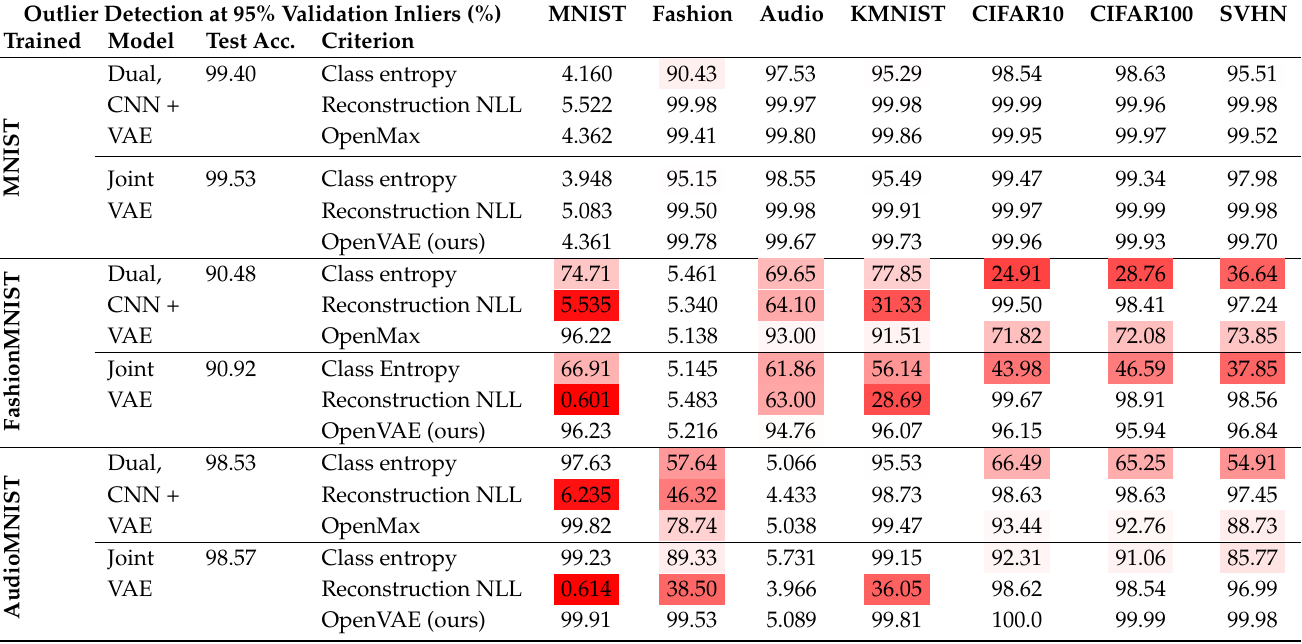
Table 1. Outlier detection values of the joint model and separate discriminative and generative models (denoted as “CNN + VAE”; discriminative convolutional neural network and variational auto-encoder), when considering 95% of the known tasks’ validation data as inlying. The percentage of detected outliers is reported based on the classifier predictive entropy, reconstruction negative log-likelihood (NLL) and our posterior-based extreme-value theory approach. Note that larger values are better, except for the test data of the trained dataset, where ideally 0% should be considered as outlying. The outlier detection values have additionally been color coded, where worse results appear in red. A deeper shading thus indicates a method’s failure to robustly recognize unknown data as such. With this color coding, we can easily see how MNIST appears to be an easy to identify dataset for all approaches; however, we notice right away that our OpenVAE is the only method (row) that does not have a single red value for any dataset combination. In fact, the lowest outlier detection accuracy of OpenVAE is a very high